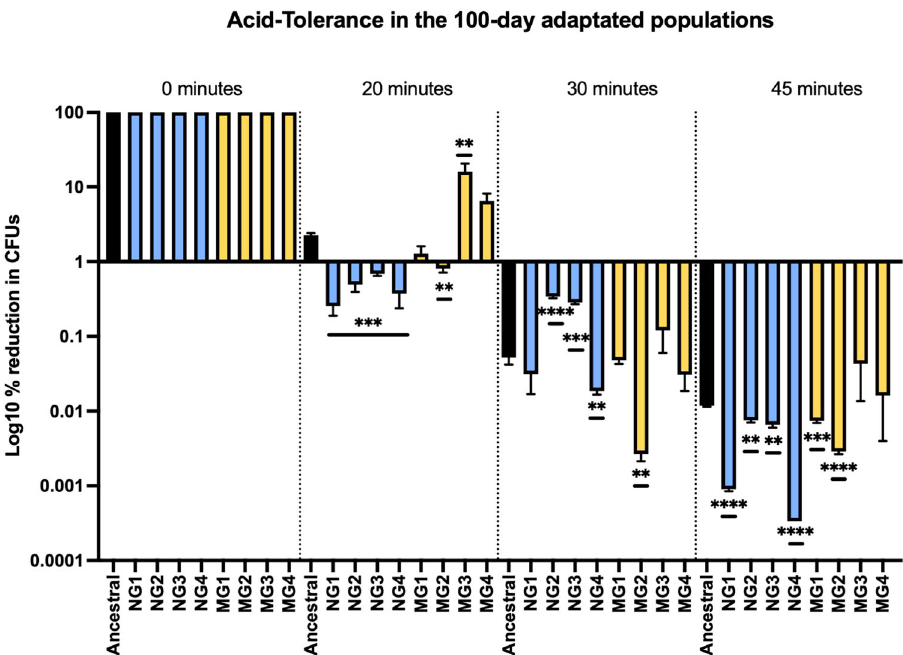
Fig. 3 Acid-tolerance changes as a result of simulated microgravity. We assessed changes in acid-tolerance after adaptation to both normal (blue) and simulated microgravity (yellow) and compared it to that of the ancestral (black). The 100-day populations were exposed to an acidic environment (glycine pH 2.8) for 0, 10, 20, and 45 min, rescued, serial diluted and CFUs were counted after 48 h of growth on BHI agar plates. The CFU counts at the 0-time point were then normalized to 100% and the % reduction was then calculated by dividing the CFU count at the indicated time points by the CFU count at 0. The values were then plotted on a log10 scale to visualize the data. Data was plotted in GraphPad Prism ® 9.2.0 and unpaired t-tests with 95% con fi dence were used to calculate signi fi cant differences for pairwise comparisons between the ancestral and each treatment populations. Error bars are s.e.m. and signi fi cance is reported as a two-tailed p-value where * p ≤ 0.05, ** p ≤ 0.01, *** p ≤ 0.001 and **** p ≤